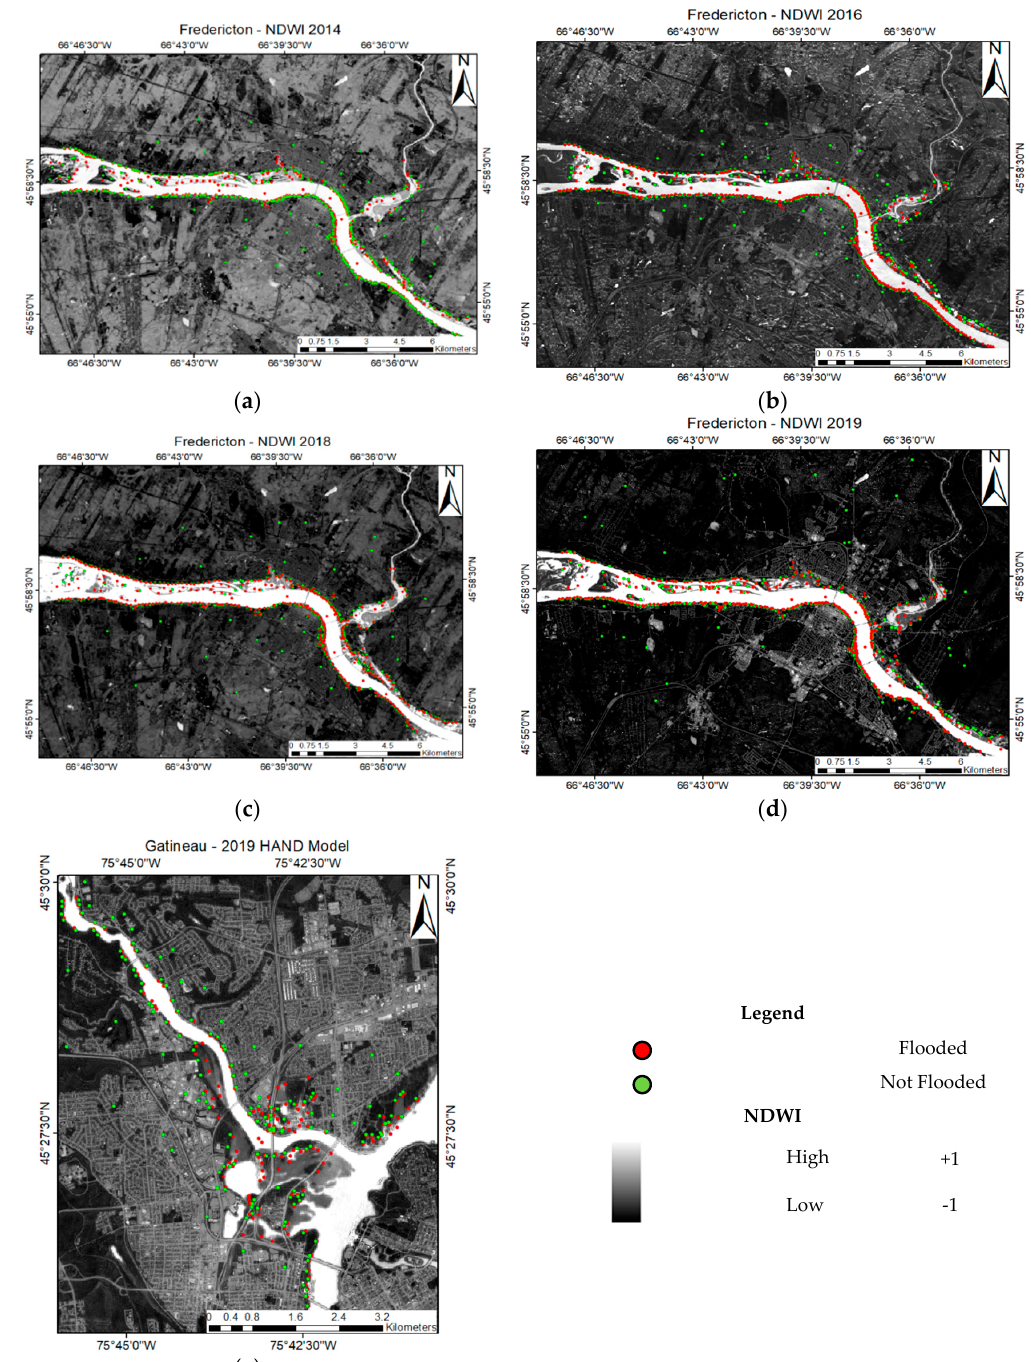
Figure 3. Normalized Water Di ff erence Index (NDWI) layers produced for ( a ) 2014, ( b ) 2016, ( c ) 2018, Figure 3. Normalized Water Difference Index (NDWI) layers produced for ( a ) 2014, ( b ) 2016, ( c ) 2018, ( d ) 2019 Fredericton and ( e ) 2019 Gatineau datasets. The green dots in the images show not-flooded ( d ) 2019 Fredericton and ( e ) 2019 Gatineau datasets. The green dots in the images show not-flooded and the red ones illustrate flooded points. and the red ones illustrate flooded (cid:1840)(cid:1830)(cid:1849)(cid:1835) (cid:3404) (cid:4666)(cid:3003)(cid:3039)(cid:3048)(cid:3032)(cid:2879)(cid:3020)(cid:3024)(cid:3010)(cid:3019)(cid:4667) . (1) (cid:4666)(cid:3003)(cid:3039)(cid:3048)(cid:3032)(cid:2878)(cid:3020)(cid:3024)(cid:3010)(cid:3019)(cid:4667) Light Detection and Ranging (LiDAR) data were used to generate the HAND model and three other conditioning factors including Altitude, Slope and Aspect. For the Fredericton datasets, the LiDAR data were obtained from the geographic data catalog website of the Province of New